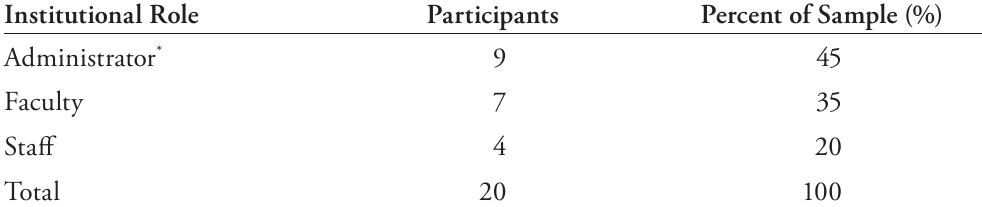
Table 2. Study Participant Institutional